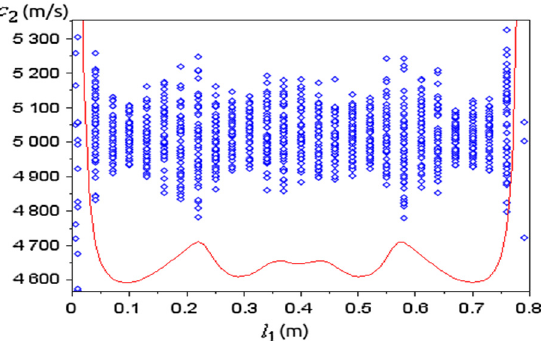
Figure 9. Optimum values of c 2 (blue dots) obtained from (14) for random sets of N = 4 resonances with frequency error ∆ f = 10 Hz, for different positions l 1 of the sample. The red line is (cid:107) ∂ c 2 (22), not to scale. The total length of the medium is